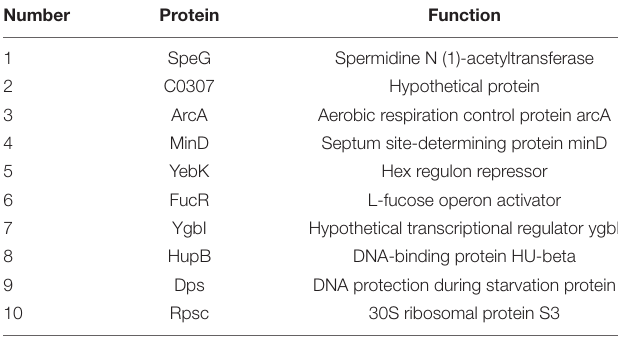
TABLE 2 | Potential proteins for regulating the yciR.